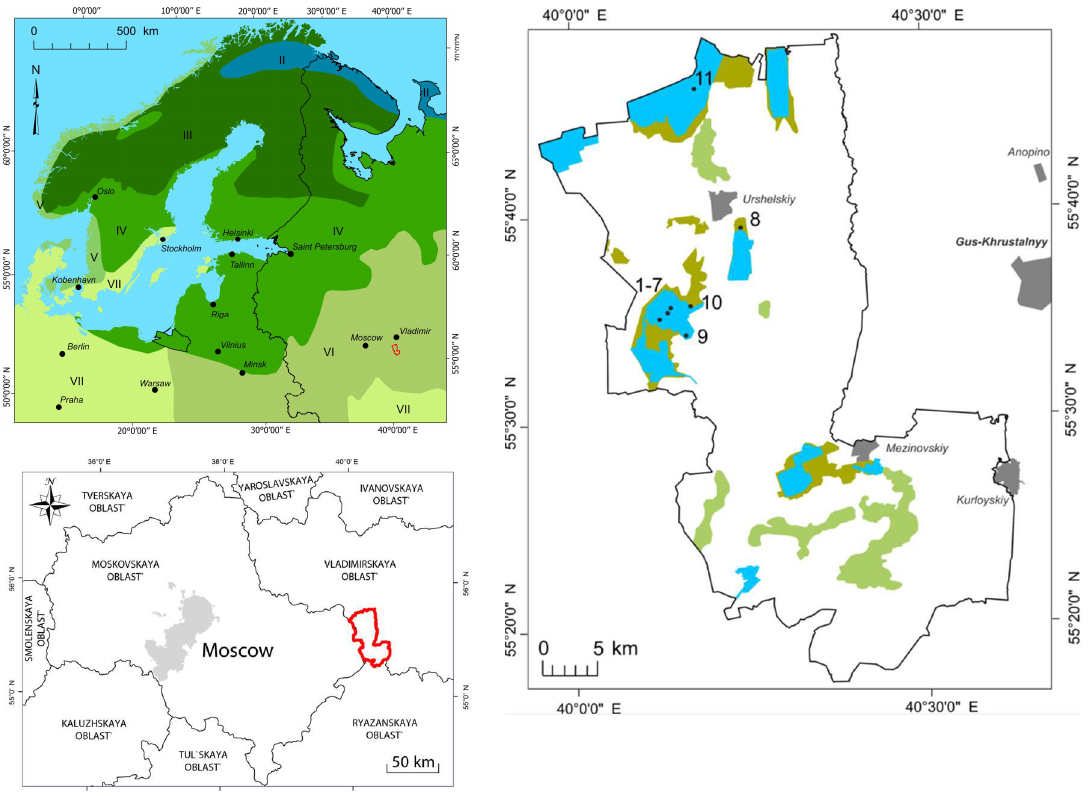
Figure 2. Location of Meshchera National Park in relation to the European mire regions, the adminis- trative boundaries of the center of European Russia: its intact mires (light green), peatlands disturbed by peat extraction (dark green), being rewetted (blue), and the location of permanent monitoring plots, 1–10 - monitoring plot numbers. The European mire regions are given against [19] as simplified from [46]: II—palsa mire region, III—northern fen region, IV—typical raised bog region, V—Atlantic bog region, VI—continental fen and bog region, VII—nemoral-sub-meridional fen